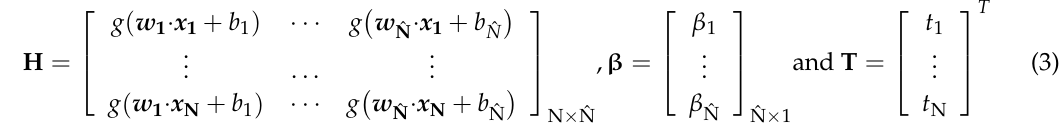
Table 2. Statistics describing organic matter content (SOM, g/kg) and pH measured in the laboratory. Properties